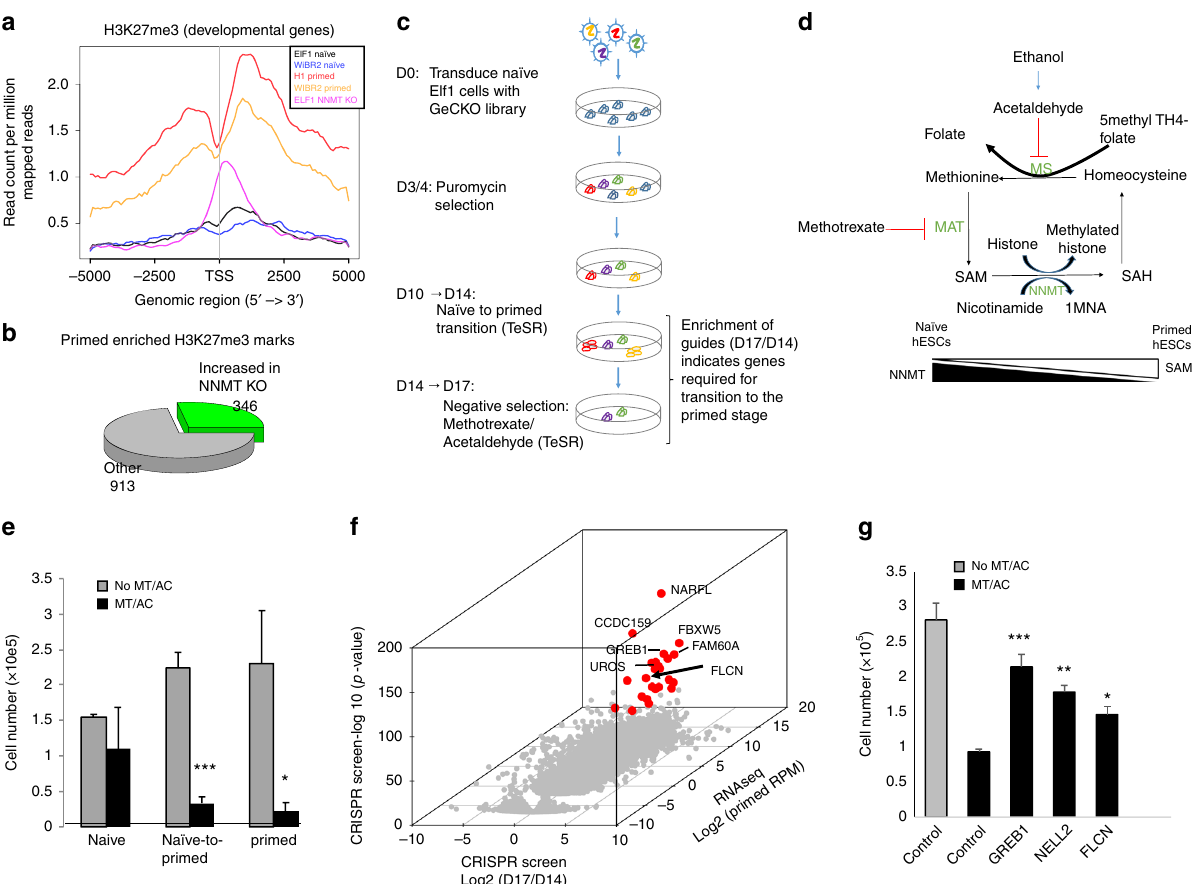
Fig. 1 CRISPR-Cas9 screen reveals FLCN as an essential gene during the exit from the naïve pluripotent state. a H3K27me3 pro fi le 5KB around transcription start site in developmental genes in naïve, primed and naive NNMT CRISPR KO samples were plotted from ChIPseq analysis. b Only 27% of the genes with H3K27me3 marks enriched in primed vs. naïve hESC are increased in NNMT KO naïve hESC. c Flowchart of genome wide CRISPR screen for exit of naïve state using GeCKO v2 library. d Schematic model of action of methotrexate/acetaldehyde selection. e Methotrexate/acetaldehyde selectively kills primed hESC and cells exiting naïve pluripotent state (4D TeSR). S.e.m.; * p < 0.05, *** p < 0.001; two-tailed t -test, n = 3 or 4 biological replicates. f CRISPR candidate hits selected by integrating CRISPR screen and RNA-seq data in primed hESC 68 . Genes that are signi fi cant CRISPR hits (FDR < 0.05, at least 2.5-fold higher in day 17 compared to day 14) and expressed in primed hESC (Elf1 AF, >10 normalized read counts) are colored in red.